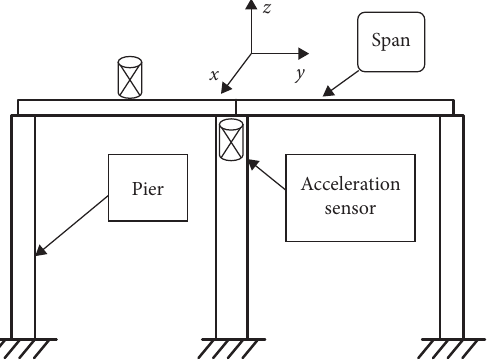
Figure 11: Plan for arranging location of vibration measurement points at Ben Noc bridge.